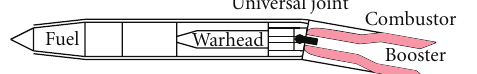
Figure 1: HyStrike fast hawk missile conceptual design.